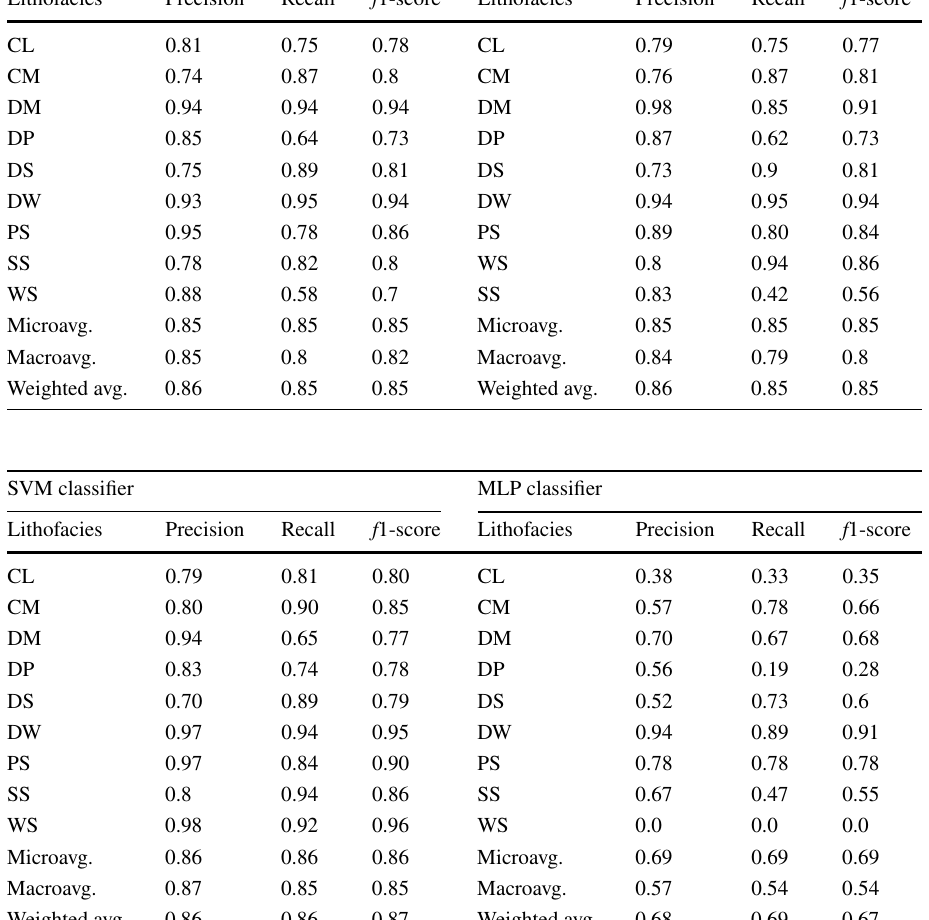
Table 5 The performance of GB classifier and RF ensembles after tenfold cross-validation for lithofacies classification